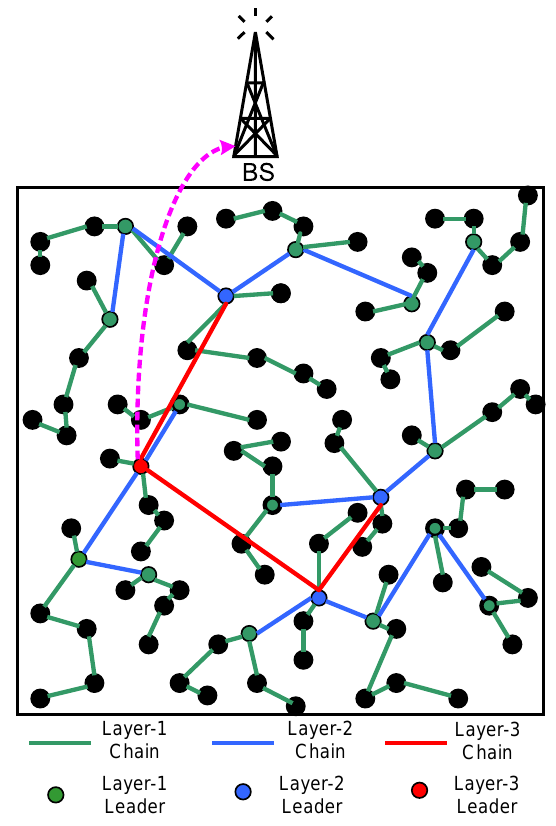
Figure 16. Three-layered hierarchical multiple chain oriented topology.